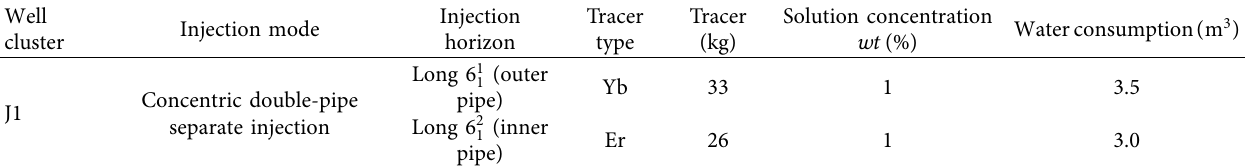
Table 2: Nanometre tracer injection process